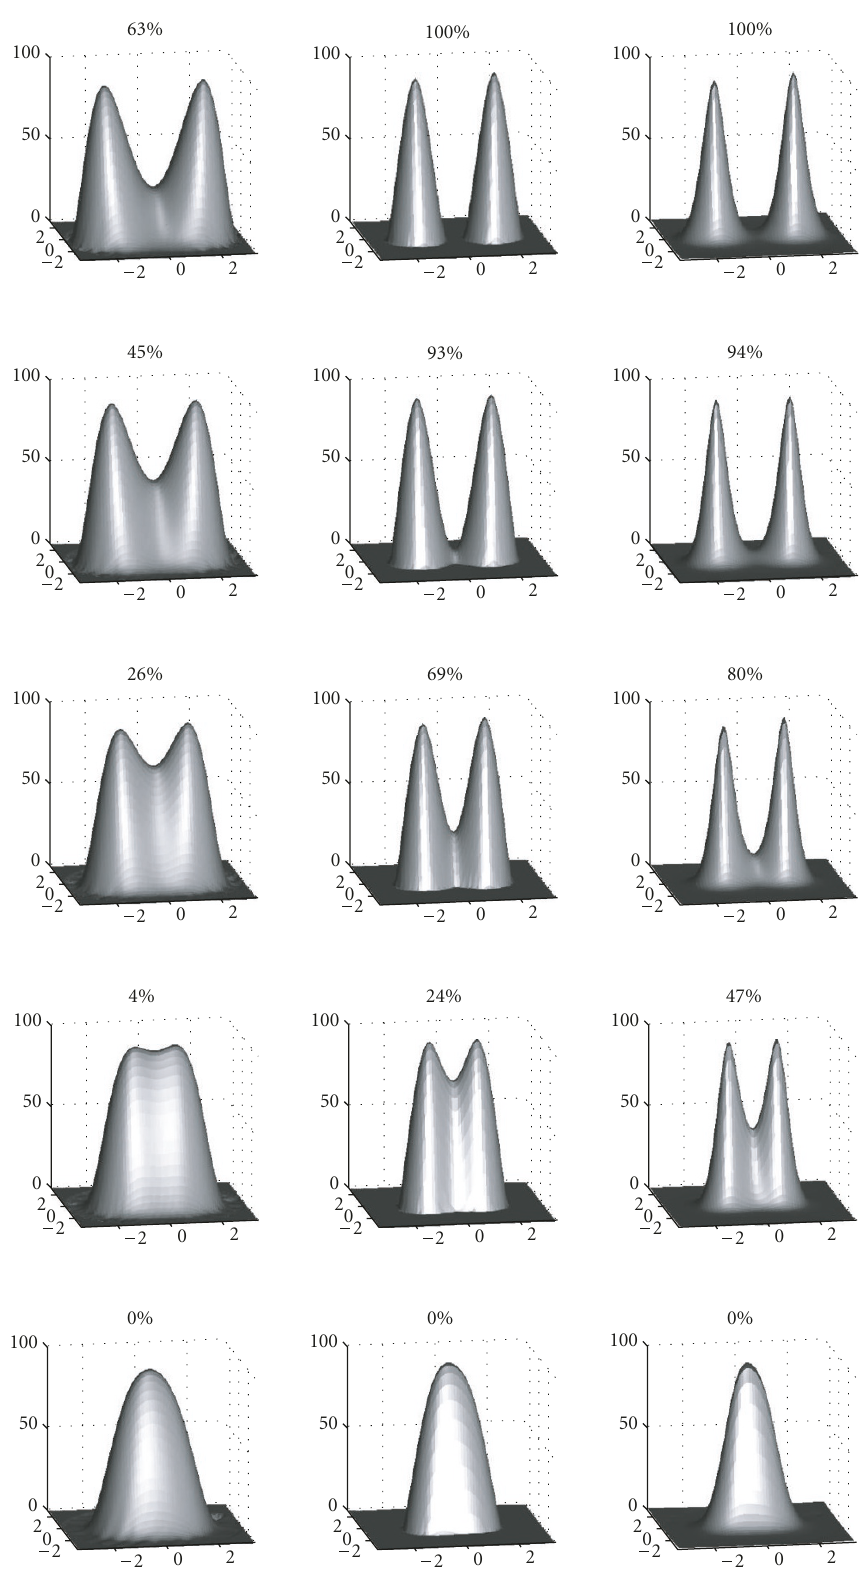
Figure 6: The best results of restoration by unpreconditioned algorithms in comparison with the results of blurred image reconstruction: the second set of